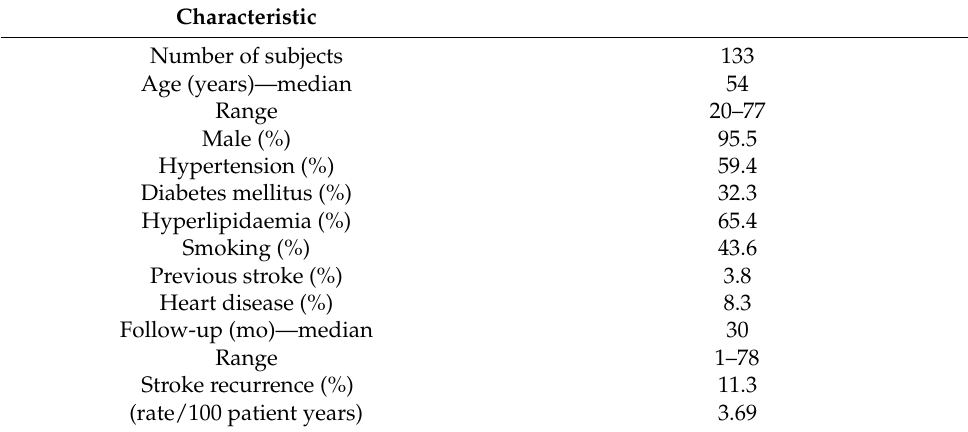
Table 1. Characteristics of recruited subjects at